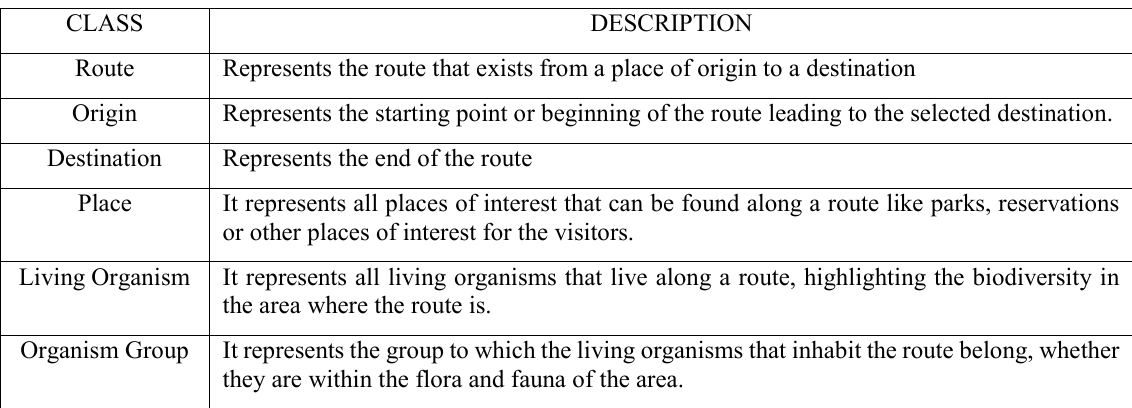
Table 1. Class of ecological tourist routes